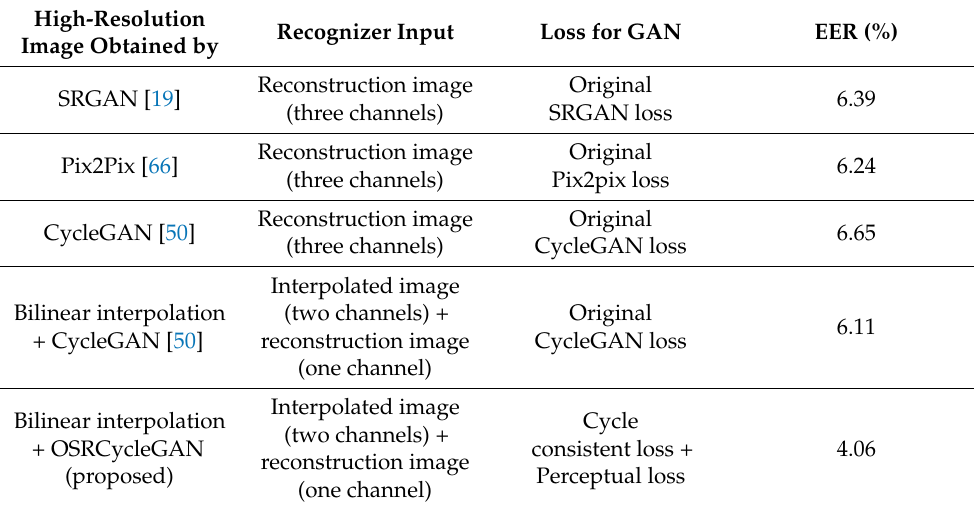
Table 9. Comparisons with state-of-the-art methods with the CASIA-Iris-Lamp database (using bilinear interpolation + Gaussian blurring when generating a low-resolution image). For the training of recognizer, train from scratch was